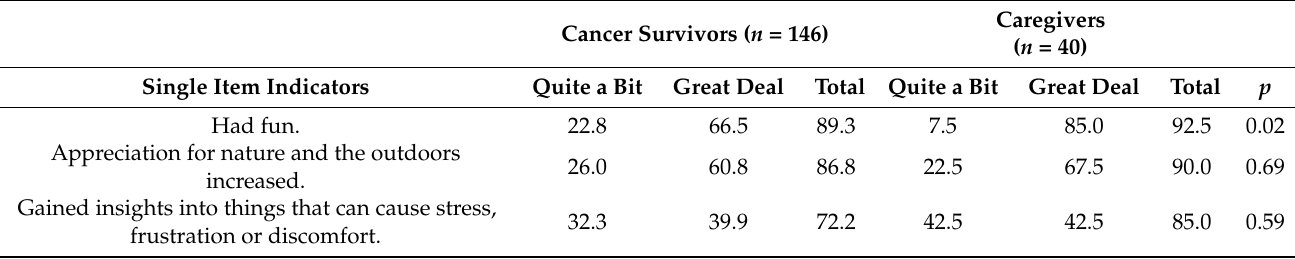
Table 3. Percentage of Post-Trek Enjoyment, Appreciation, Insights, and Learning